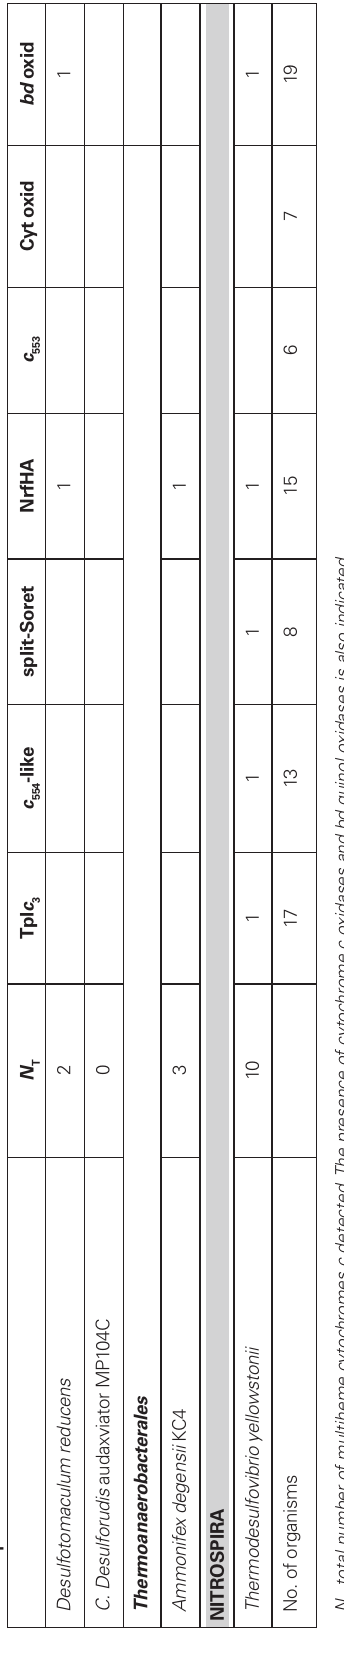
Table A3 | Analysis of nfnAB gene distribution in the SRO